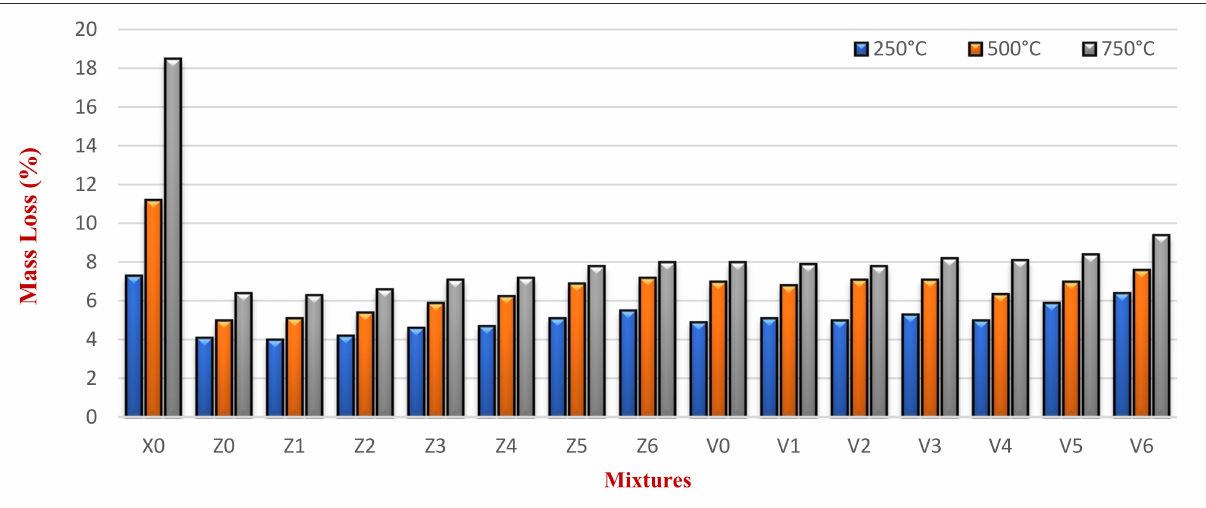
Figure 14. HWHPC mass loss (%) under fire